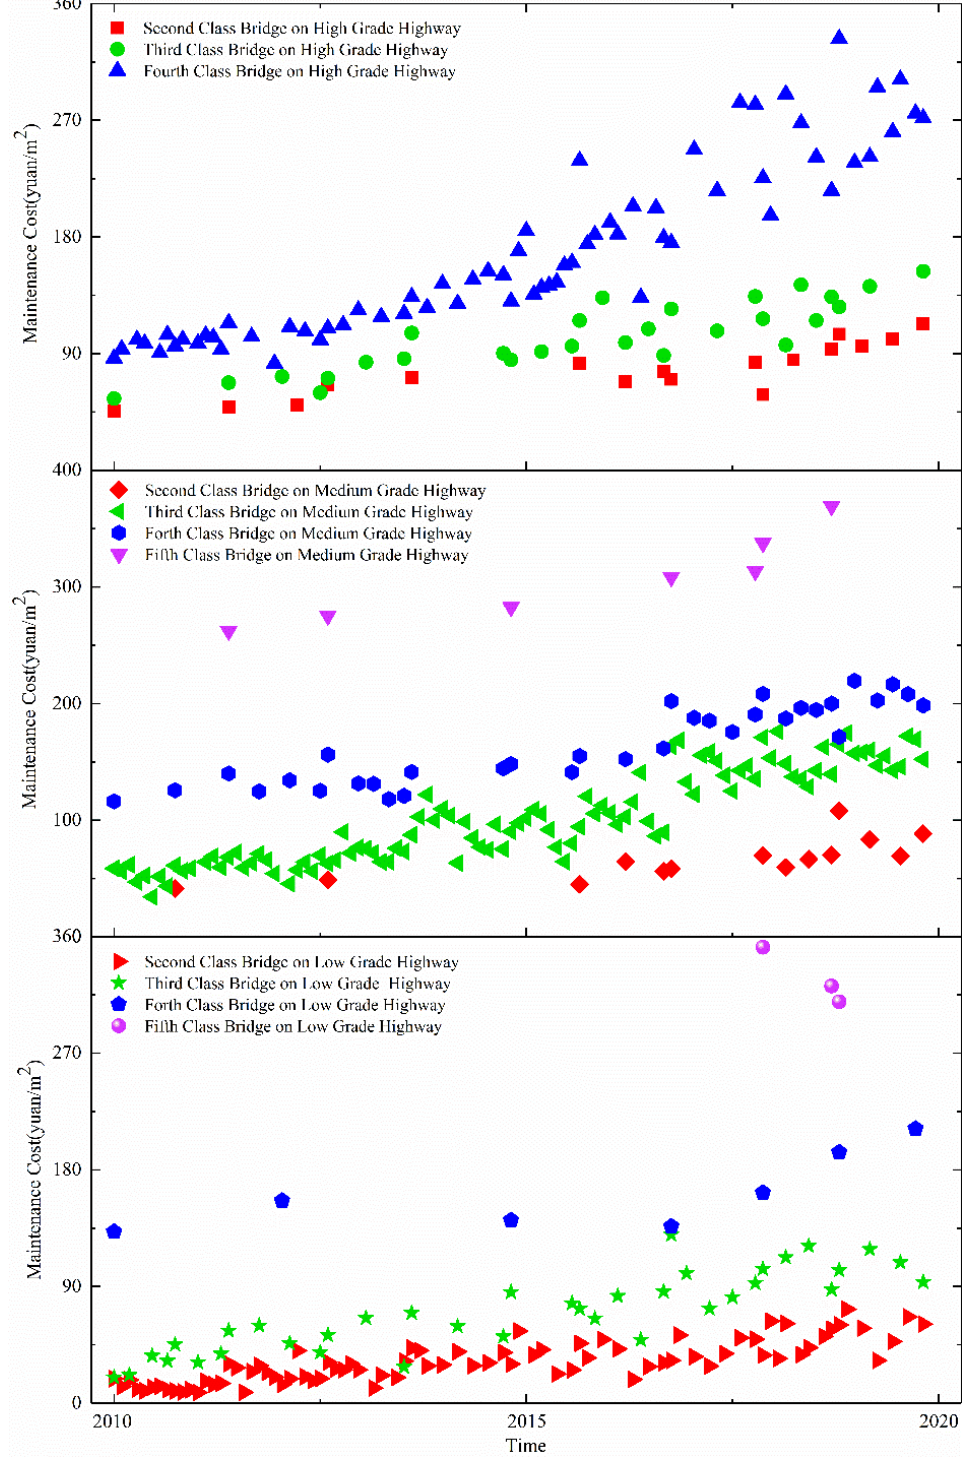
Figure 9. Sample classification chart.